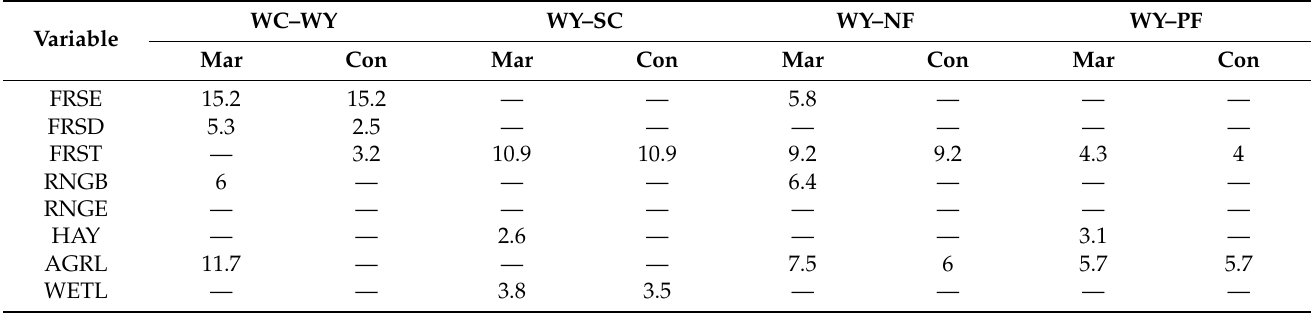
Table 7. Marginal and Conditional Effects from the Summary of Forward Selection for Different ES Tradeoffs.